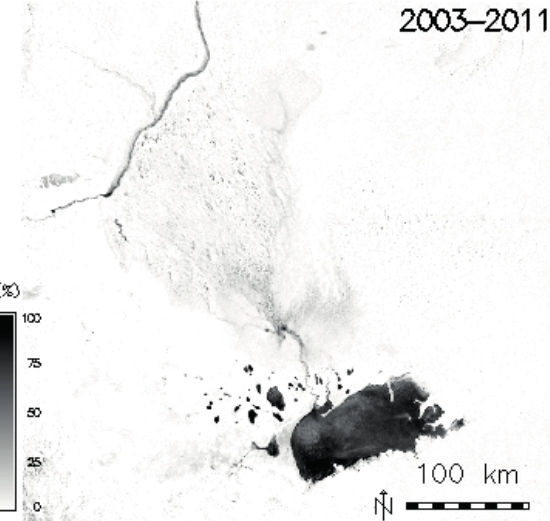
Fig. 1 Spatial distribution of the probability of the existence of surface water around the CSSWs obtained using the NDWI